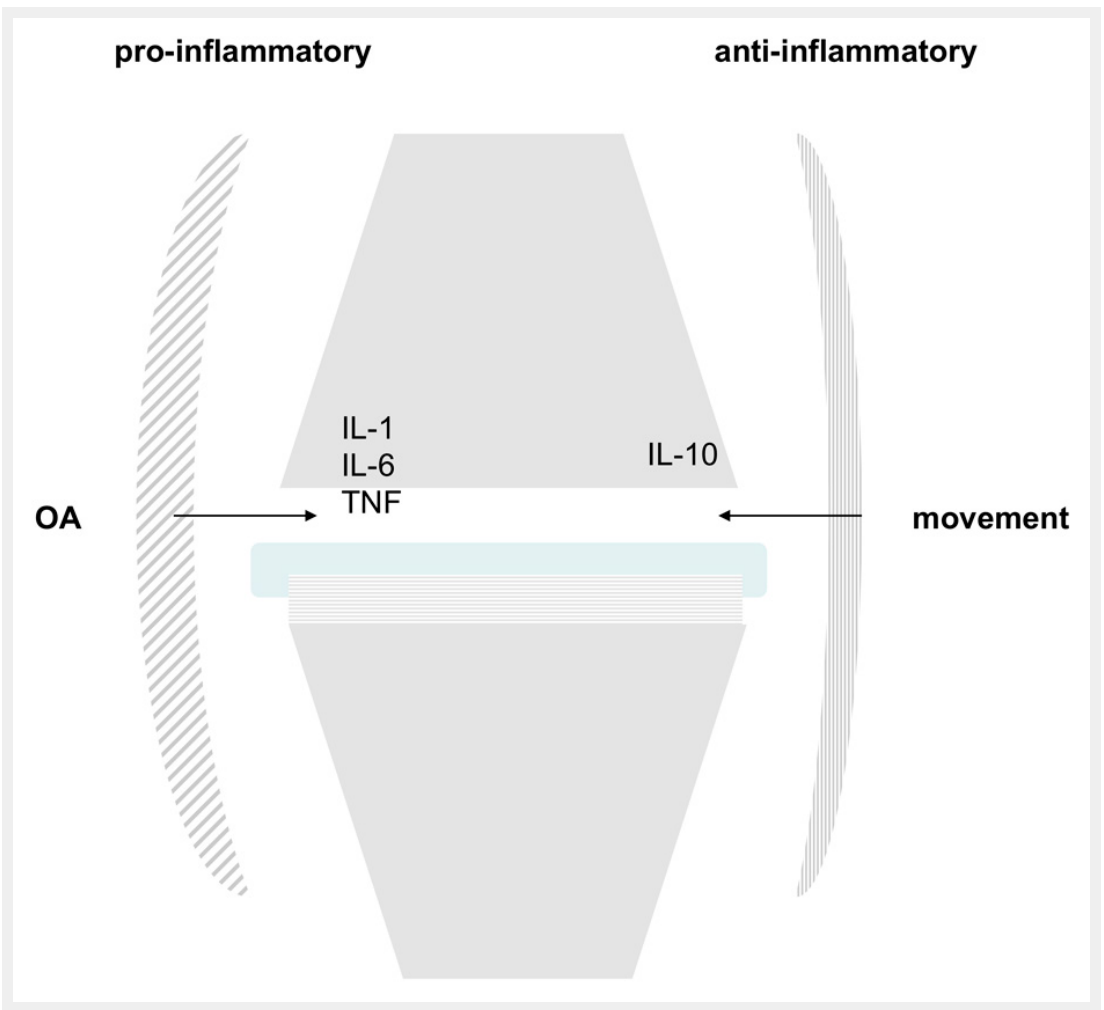
Figure 3 Cytokine expression in OA and movement. Synovitis related to OA leads to the secretion of proinflammatory cytokines such as IL-1,6 or TNF- alpha. Under normal circumstances, joint movement induces IL-10, a potent anti-inflammatory